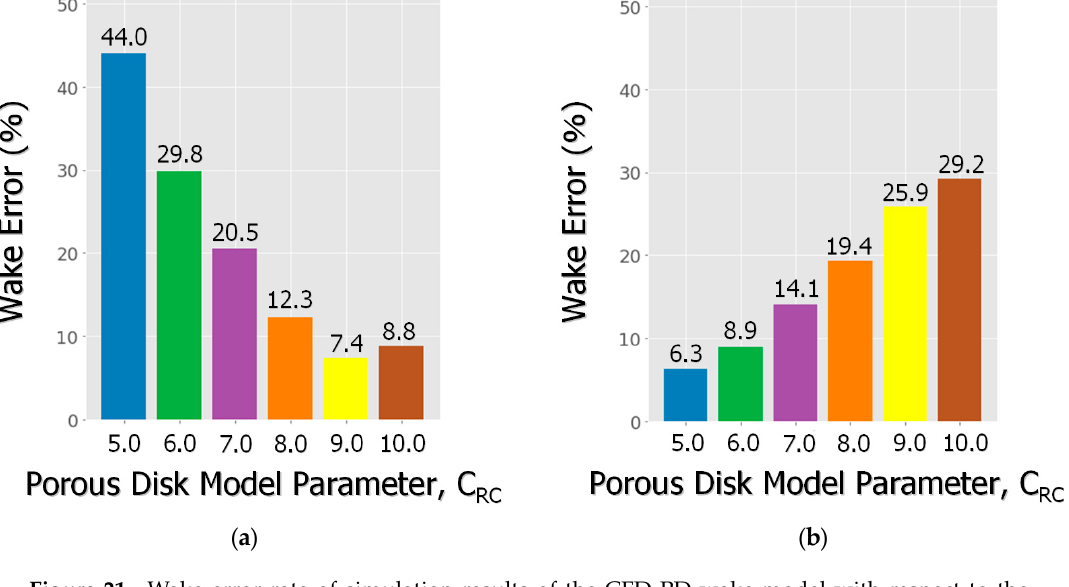
Figure 21. Wake error rate of simulation results of the CFD PD wake model with respect to the simulation results by ANSYS(R) CFX(R) in the case of a real wind turbine. ( a ) x = 5D (near wake region); ( b ) x = 10D (far wake region). The comparison of wake error rates was evaluated based on the simulation results shown in Figure 21.